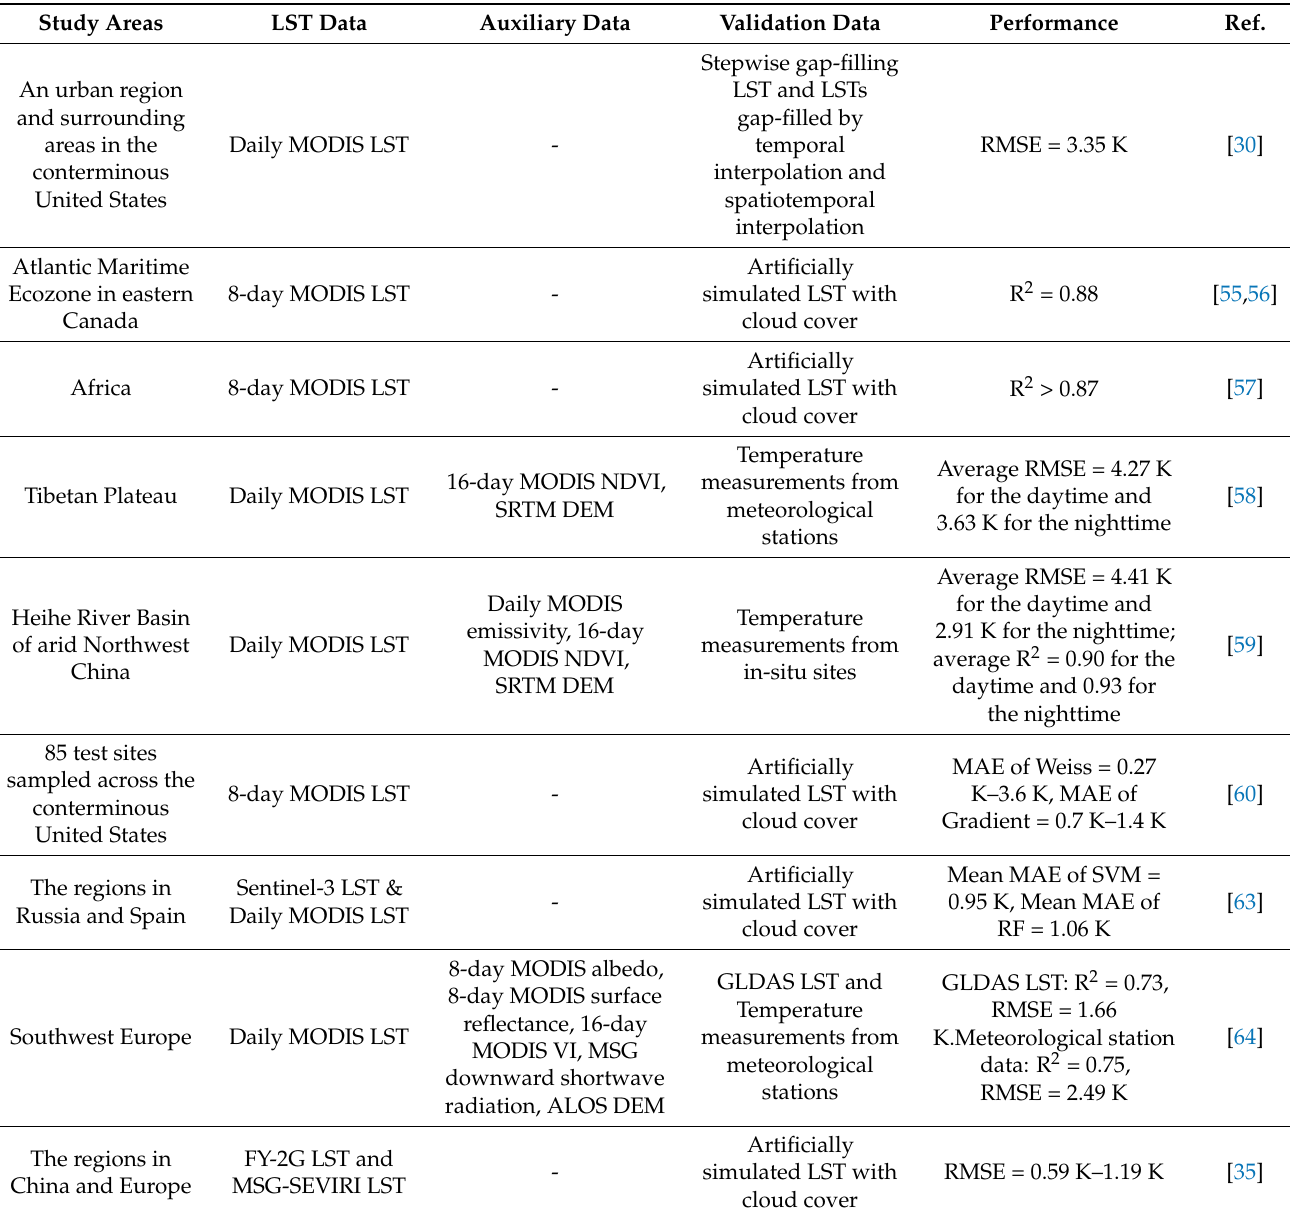
Table 6. Summary of spatiotemporal gap-filling